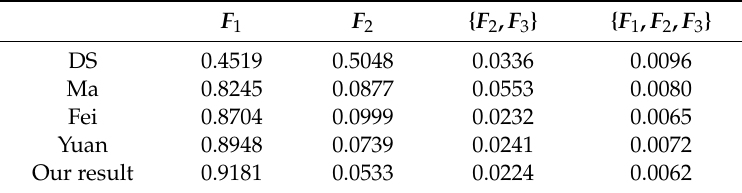
Table 9. Fusion results of di ff erent combination